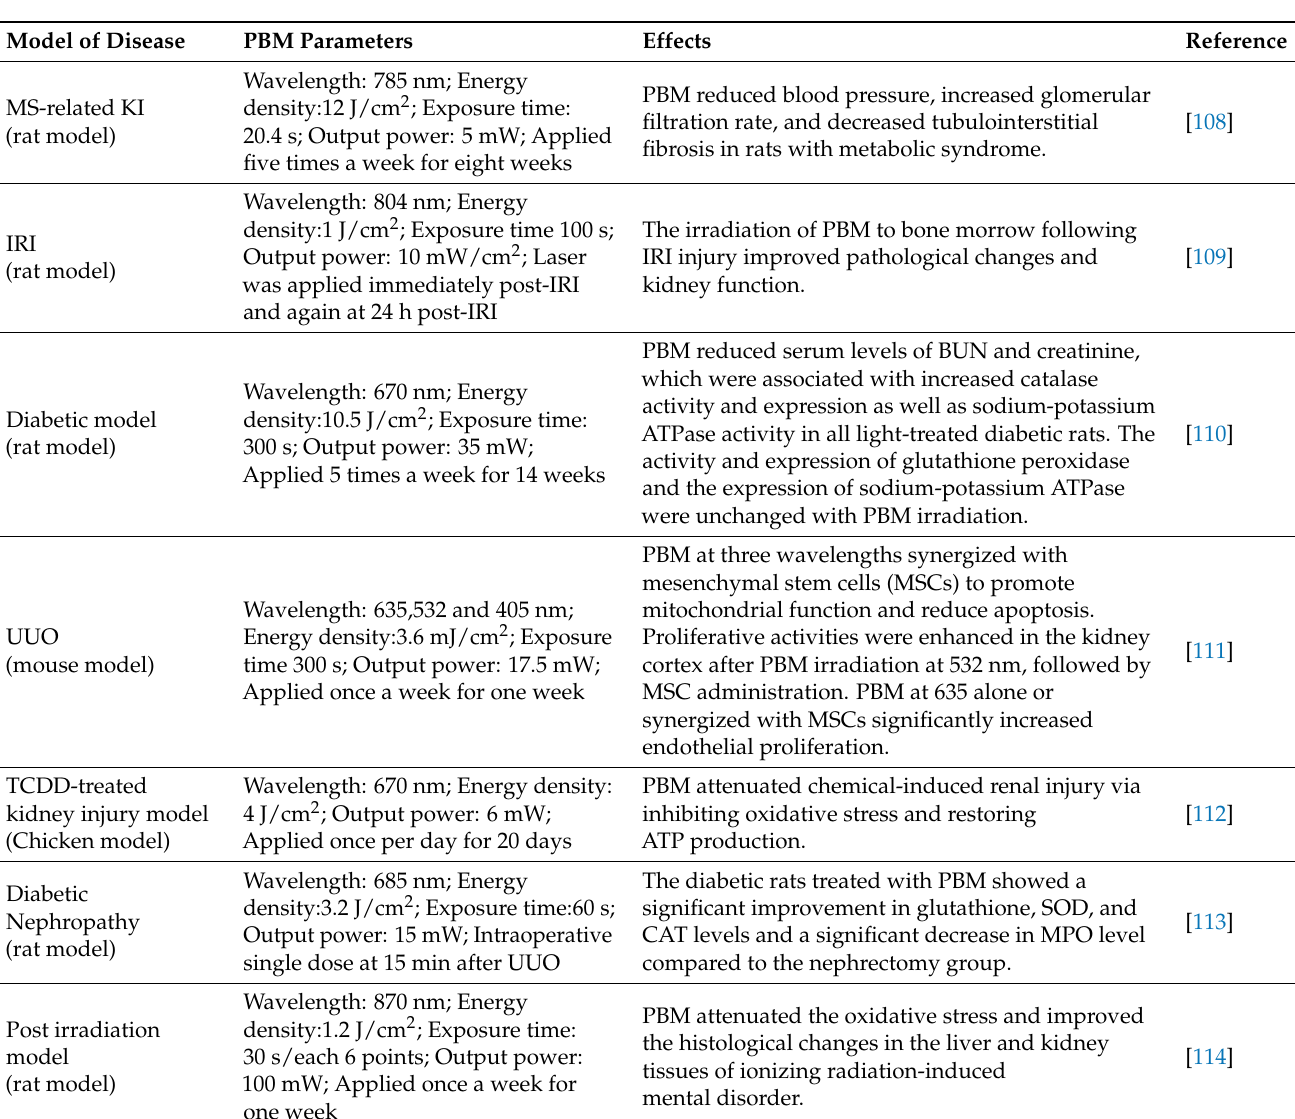
Table 1. PBM studies in kidney diseases. Model of Disease PBM